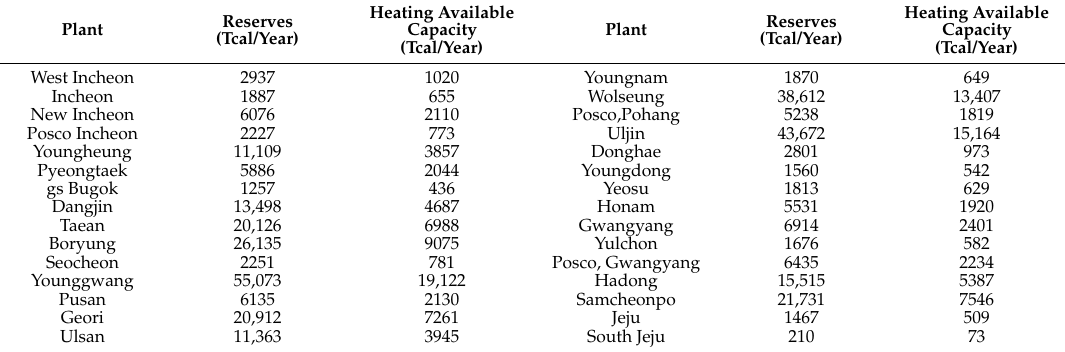
Table 2. Energy reserves and heating available capacity of each power plant. Heating Available Plant Reserves (Tcal/Year) Capacity Plant Reserves (Tcal/Year) (Tcal/Year)